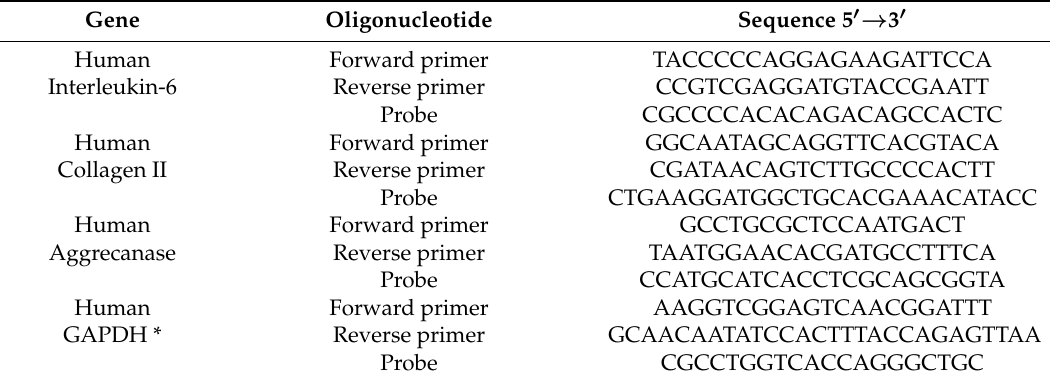
Table 1. Primer and probe